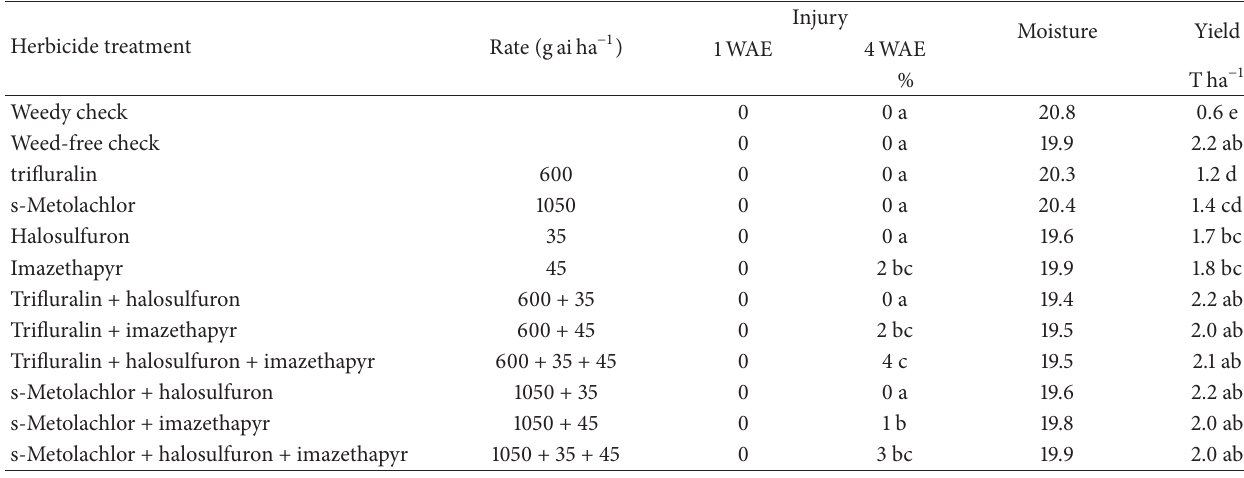
Table 1: Percent visible injury 1 and 4 WAE, crop moisture at harvest, and yield of white bean treated with halosulfuron tankmixes applied PPI at Exeter (2011–2013) and Harrow, ON (2012). Means followed by the same letter within a column are not significantly different according to Fisher’s Protected LSD at 𝑃 < 0.05 a